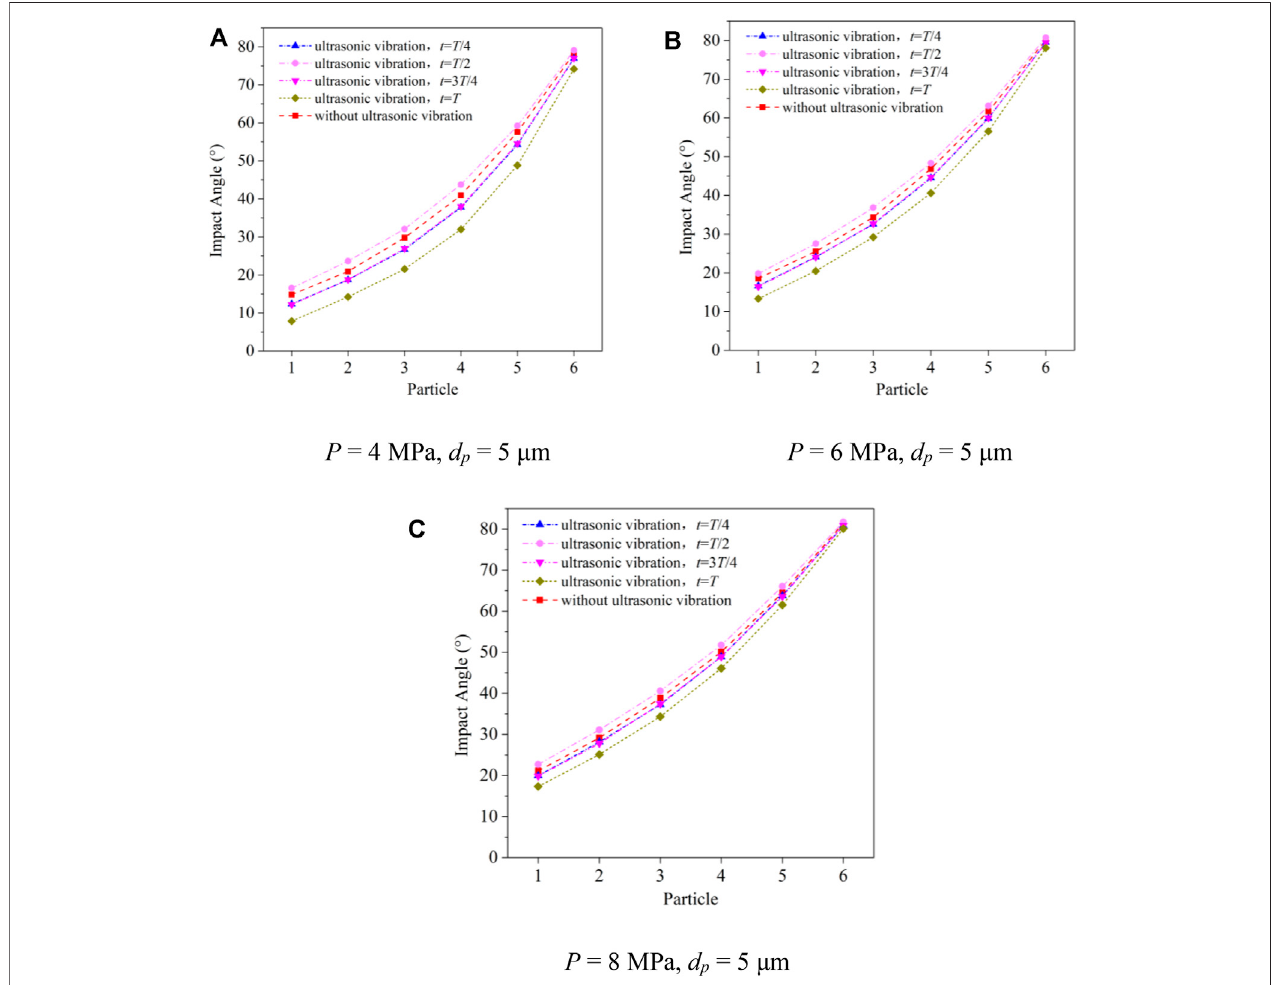
FIGURE 9 | Effect of ultrasonic vibration on the collision angle of the abrasive particles in the jet fi eld. (A) P = 4 MPa, d p = 5 μ m, (B) P = 6 MPa, d p = 5 μ m, (C) P = 8 MPa, d p = 5 μ